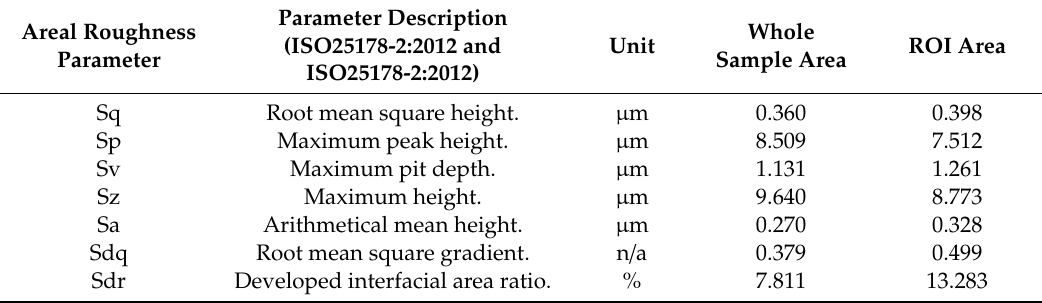
Table 2. Computed areal roughness parameters for the whole sample and the region of interest (ROI) areas, indicated in Figure 17c.